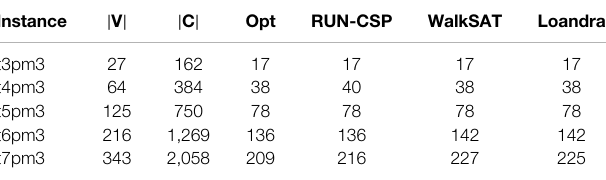
TABLE 2 | M AX -C UT : P -values of graph cuts produced by RUN-CSP, Yao, SDP, and EOforregular graphswith500nodes and varyingdegrees. Wereportthe mean across 1,000 random graphs for each